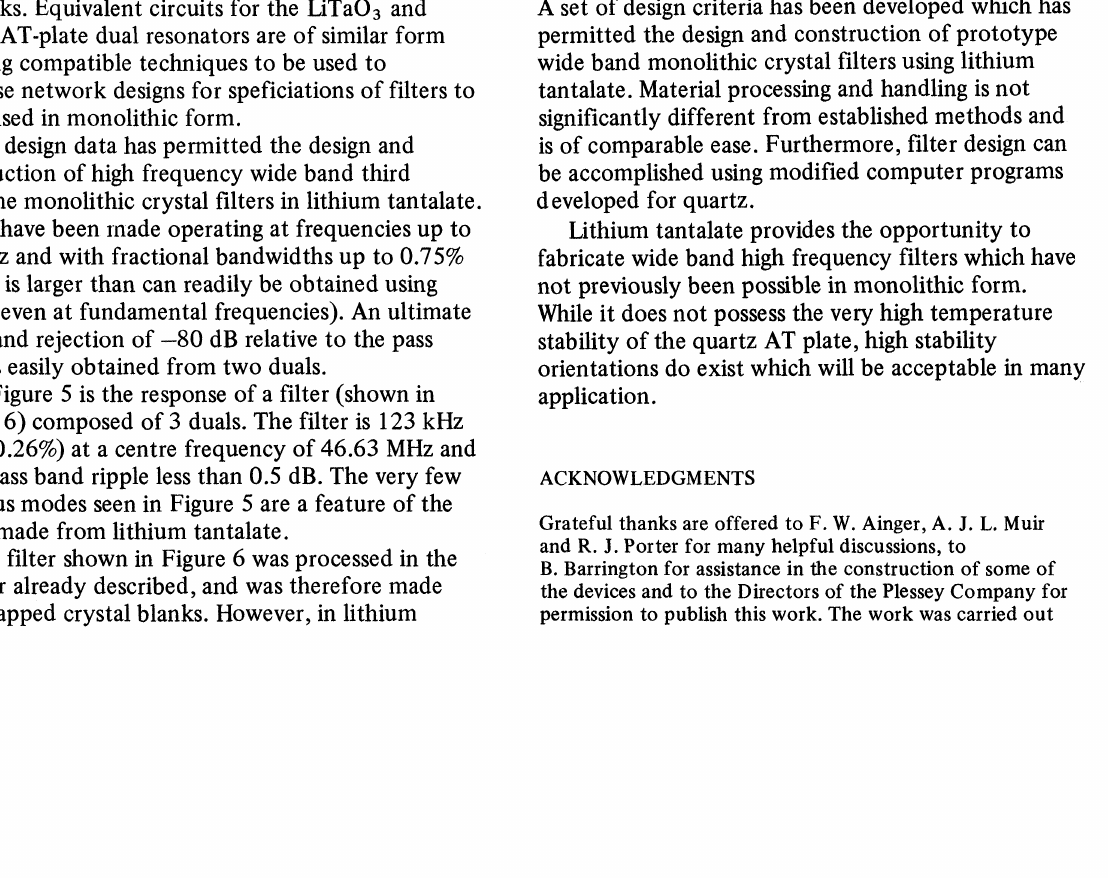
A LiTaO monolithic crystal filter comprising three coupled dual resonator units and coupling capacitors (not